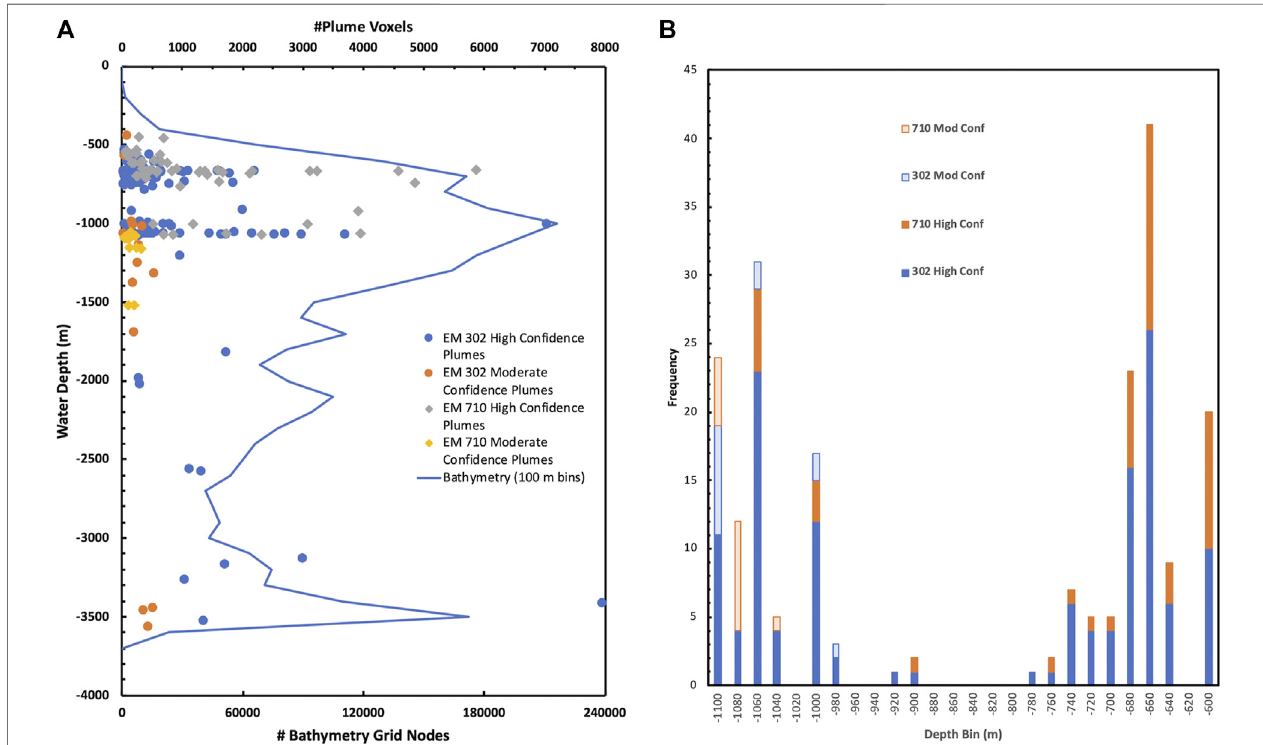
FIGURE4| Observeddepthdistributionofwatercolumnanomalies(bubbleplumes)forEM302andEM710datasets.NotethatEM710sonardeactivated inwater depths > ca. 1000 m. (A) Bubble plumes plotted as number of voxels (points) in fi nal Fledermaus model vs. depth for High and Moderate Con fi dence plume interpretations.Bottomaxis(bluecurve)recordsnumberofbathymetrynodesin100 mbinstotestforpossiblecoveragebias(e.g.,between800and1000 mwherefew plumes identi fi ed). (B) Histogram of EM302 and EM710 High and Moderate Con fi dence bubble plumes binned in 20 m increments. Note paucity of observations between 800 and 1000 m water